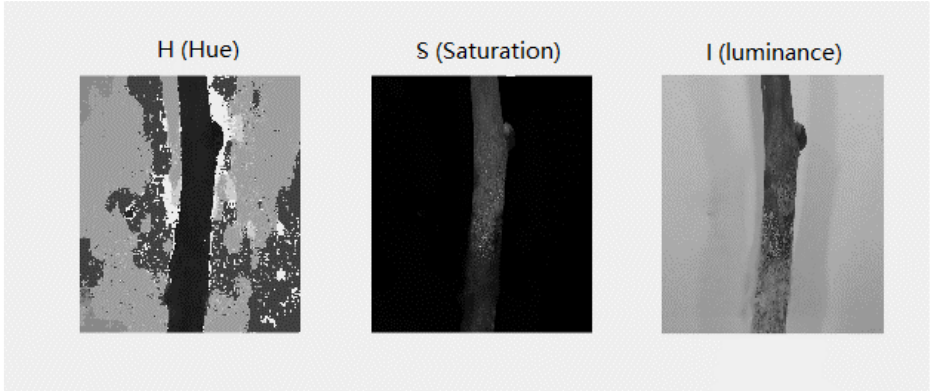
Figure 8. HSL component map of disease images.